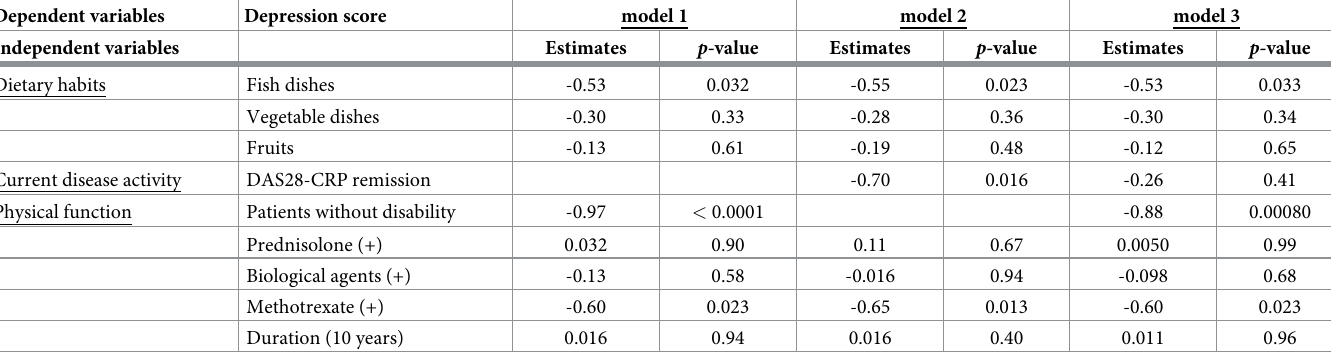
Table 3. Multivariate analyses for independent factors associated with depression scores including factors of dietary